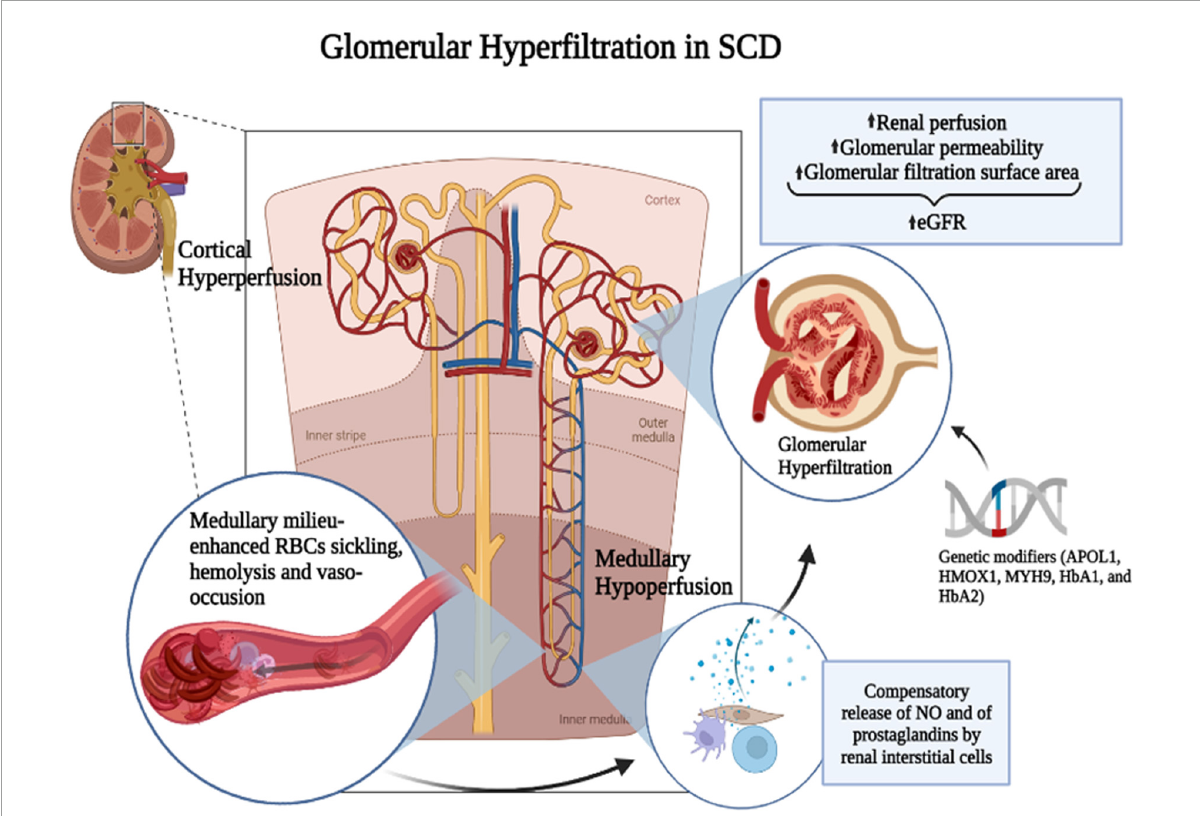
FIGURE1 Mechanism of SCD-induced glomerular hyperfiltration. The hypoxic, acidic, and hyperosmolar environment of the renal medulla promotes the polymerization of HbS and the sickling of RBCs. Slow blood rheology in the vasa recta aggravates the vaso-occlusion and leads to ischemia that can advance to infarction. As a compensatory mechanism, medullary prostaglandins and nitric oxide (NO) are secreted leading to an increased renal cortical flow. It was suggested that prostaglandins are released by renal interstitial cells. Genetic modifiers such as APOL1, HMOX1, MYH9, HbA1, and HbA2 and increased renal perfusion coupled with increased glomerular permeability and glomerular filtration surface area may enhance glomerular hyperfiltration in SCD. Figure created with